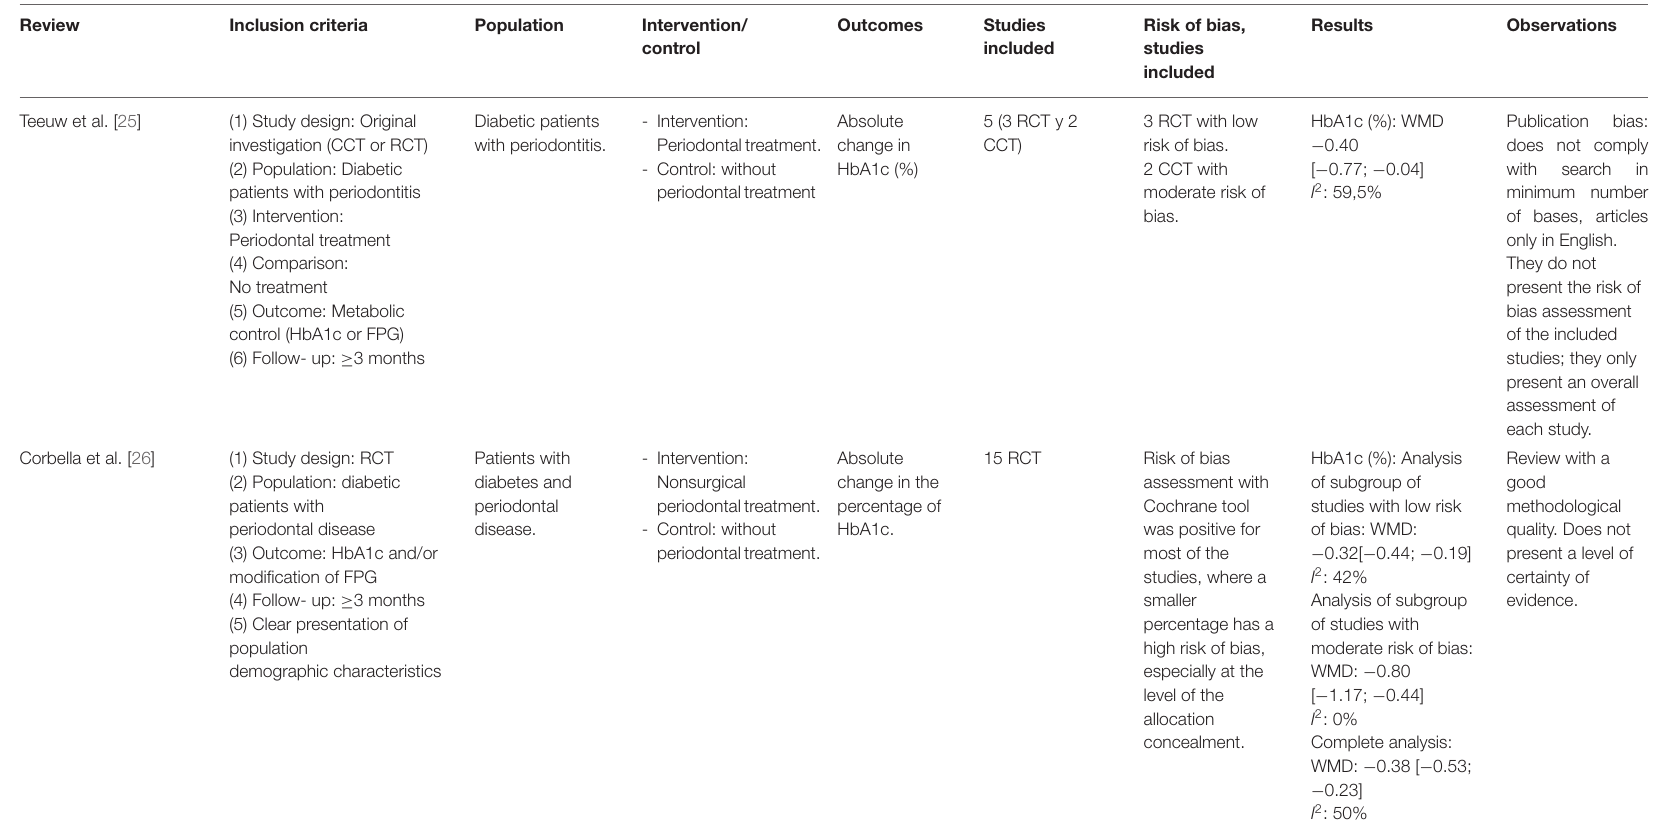
TABLE 4 | Description of reviews included in question 3.